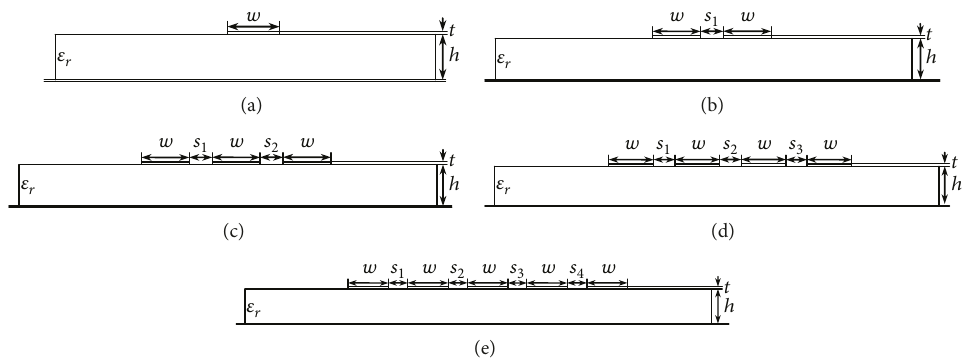
Figure 1: Cross sections of one- (a), two- (b), three- (c), four- (d), and fi ve- (e) conductor structures.